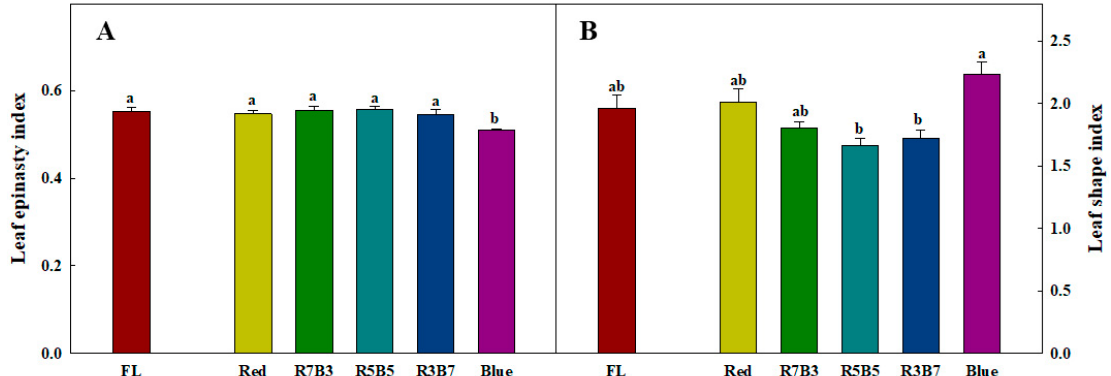
Figure 3. Leaf epinasty index ( A ) and leaf shape index ( B ) of Salvia plebeia R. Br. as affected by different light treatments at 35 days after transplanting. Vertical bars represent the standard deviation from the mean ( n = 3). Different letters in the same column indicate significant differences based on Tukey’s multiple range test ( α ≤ 0.05).